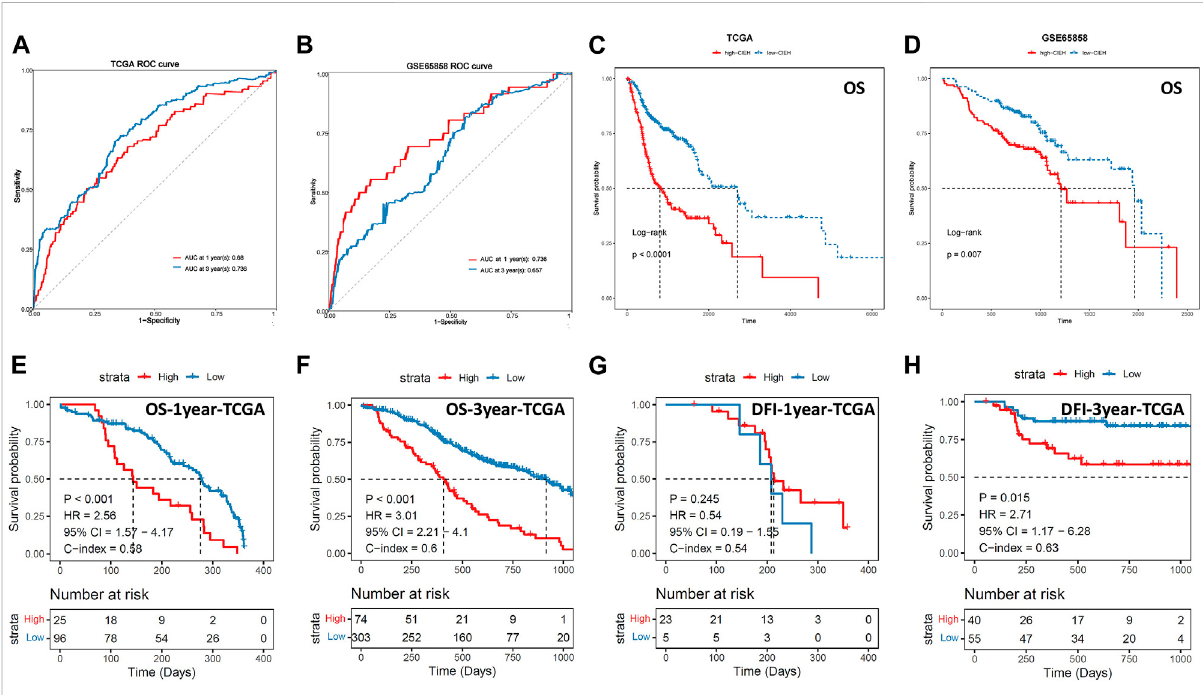
FIGURE 3 Effectiveness analysis of CIEH model prediction. (A,B) . ROC curves of CIEH values of TCGA and GSE65858 data sets. (C,D) . Overall survival analysis of TCGA and GSE65858 in high and low CIEH groups ( p < 0.05). (E) . The 1-year overall survival analysis of TCGA ( p < 0.05). (F) . The